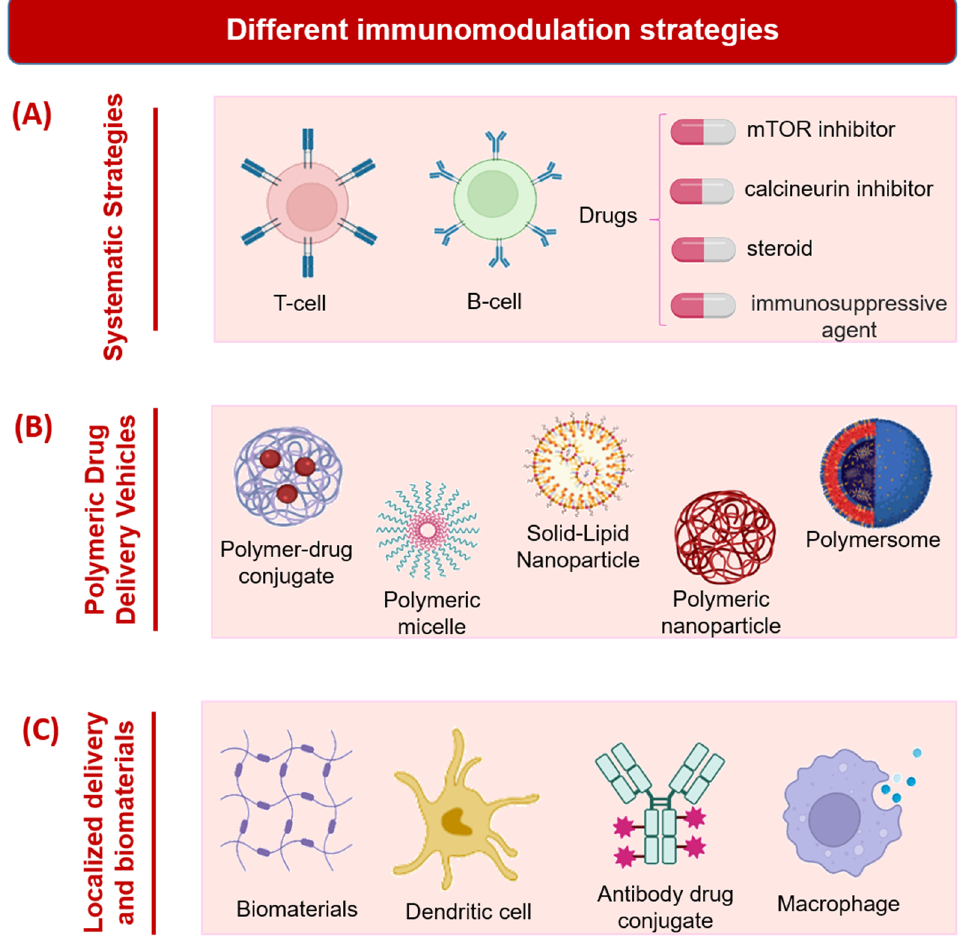
Figure 3. Different immunomodulation strategies. ( A ) Systematic strategies. ( B ) Polymeric drug de- livery vehicles. ( C ) Localized delivery and biomaterials. Schematics prepared using Biorender.